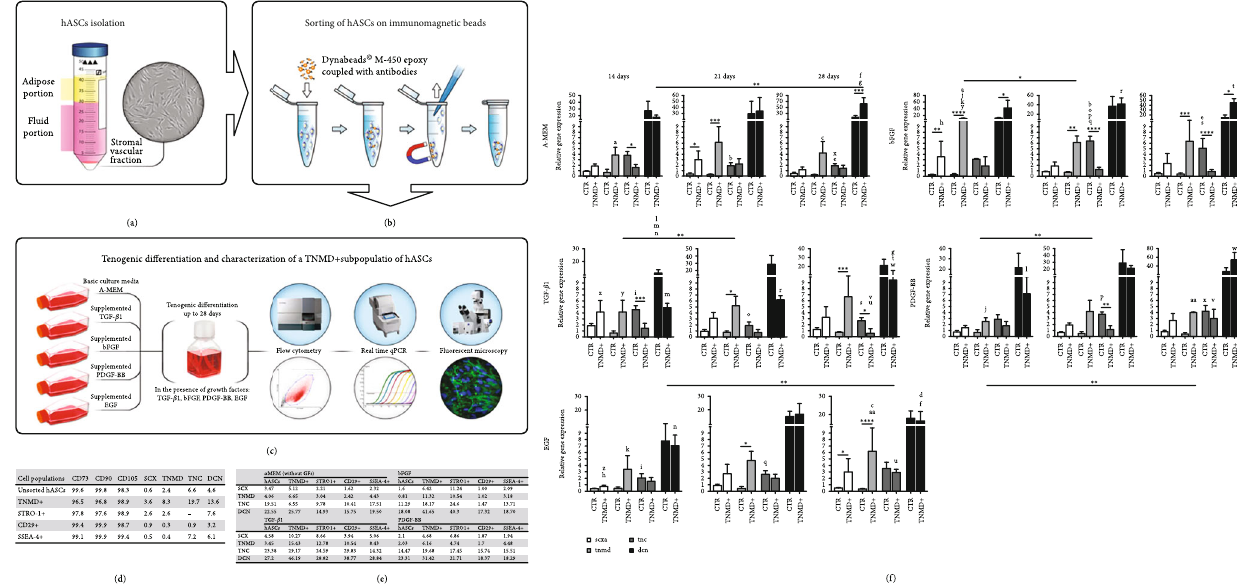
Figure 6: Schematic representation of steps to sort subpopulations of hASCs: (a) isolation of hASCs, (b) immunomagnetic sorting of hASCs, (c) tenogenic di ff erentiation of TNMD + hASCs, (d) expression of tendon-related markers in sorted and unsorted subpopulations of hASCs, (e) response of sorted and unsorted subpopulations of hASCs to di ff erent growth factors, and (f) gene expression level of Tnmd, Scx, TNC, and DCN in sorted subpopulations of hASCs. Reproduced with permission from reference